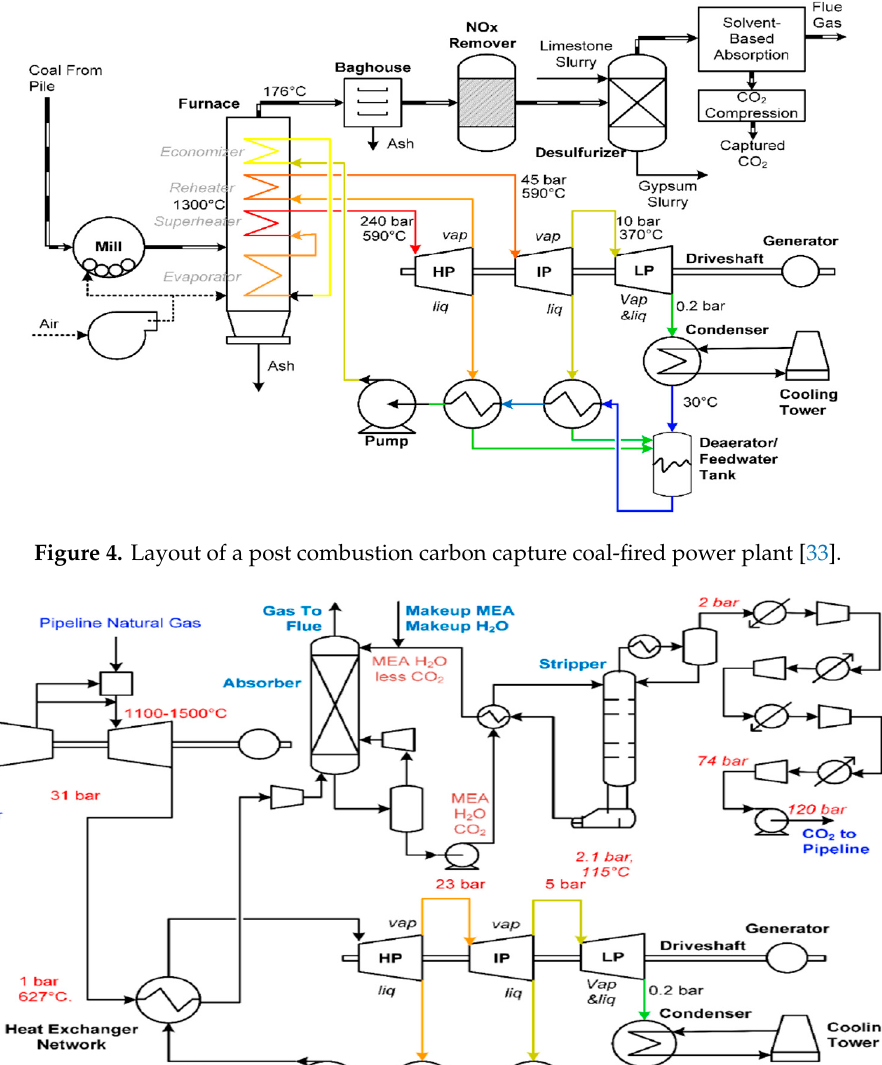
Figure 3. Schematic diagram of a simplified flue gas cleanup process for post combustion carbon capture [32].